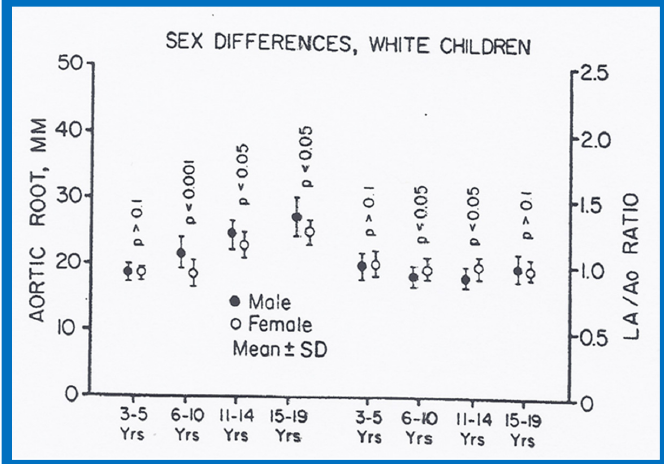
Figure 33. Gender ‐ related differences in the measurements of aortic root and left atrium are illustrated for male white (filled circles) and female white (unfilled circles) children. Means and standard deviations (SD) are shown. Note that there is no consistent difference for all age groups in the aortic root and left atrial sizes between male and female white children. Reproduced from Rao P.S., Thapar M.K. [10]. When racial differences were examined, larger ( p < 0.05 to 0.0001) LA and/or LA/Ao ratio in black than white children of all age ‐ sex subgroups were found (Figure 34). Also, a thicker LV posterior wall and/or LV muscle mass (in black than in white) was found in most age–gender subgroups (Figure 35). The weight, height, body surface area, chest circumference, antero ‐ posterior diameter of the chest and blood pressure were similar ( p > 0.05), but lower ( p < 0.05 to 0.01) hemoglobin levels in